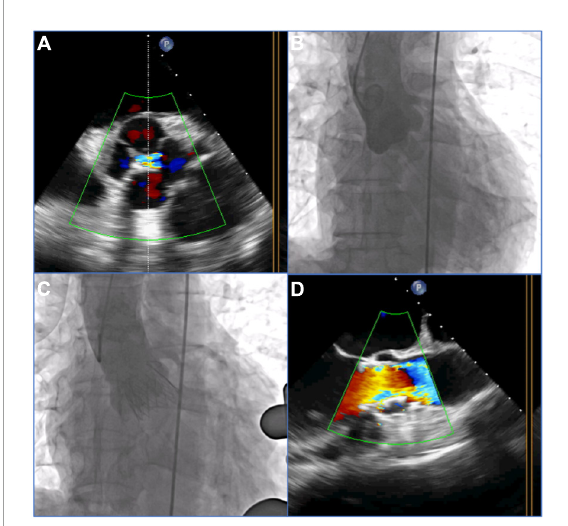
FIGURE2 Procedural details of transcatheter aortic valve replacement (TAVR) with the self-expandable J-Valve prosthesis in a patient with a quadricuspid aortic valve with pure aortic regurgitation. (A) 2-Dimensional transesophageal echocardiography (TEE) with color Doppler showed aortic regurgitation in the quadricuspid aortic valve before the procedure. (B) Preoperative angiography showed four sinuses and aortic regurgitation. (C) Postoperative angiography showed the final position of a 29 mm J-Valve prosthesis without a paravalvular leak after deployment. (D) 2-dimensional TEE with color Doppler showed no aortic regurgitation postprocedure.